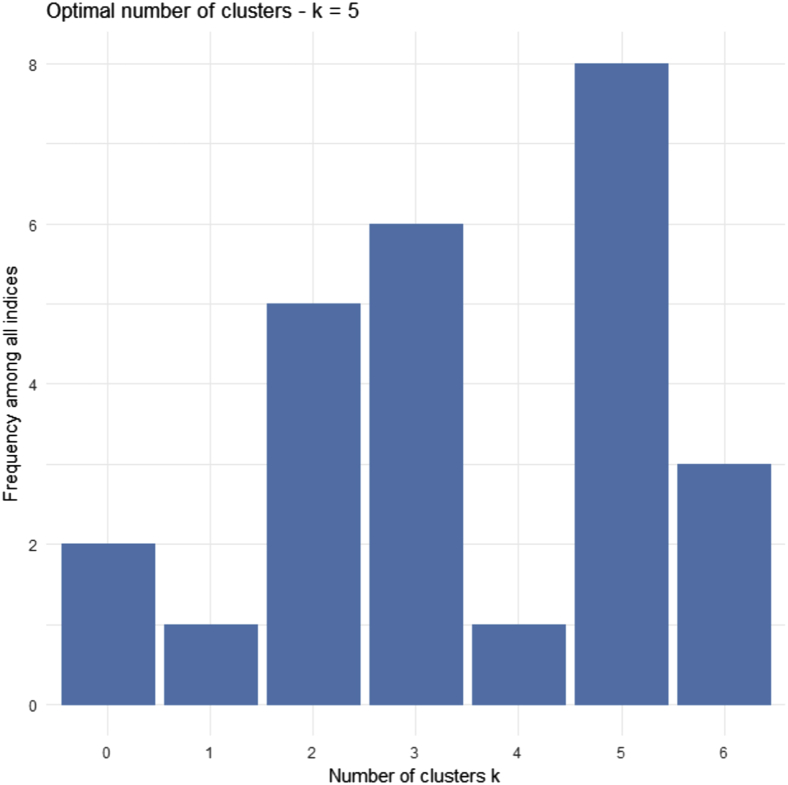
Evaluation measures distribution for the choice of the optimal number of cluster obtained with the package NbClust.